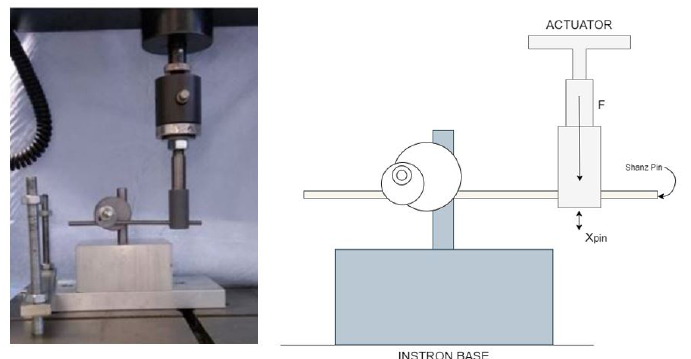
Figure 7. Diagram of interface test. The schanz pin is fixed on to the instron base using the 2 clamps used in the pin clamp assembly. The actuator provides a loading perpendicular to the pin axis.